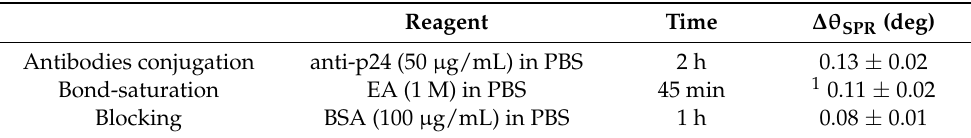
Table 2. Experimental condition used for the modification of the activated mixed-SAM in the SPR apparatus. The reagent composition, time of exposure, and SPR response is reported for each biofunctionalization